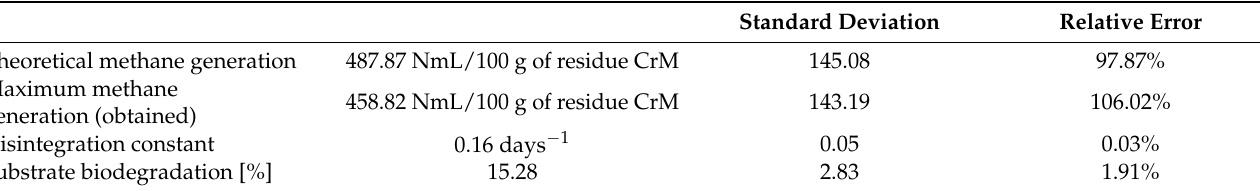
Standard Deviation Relative Error